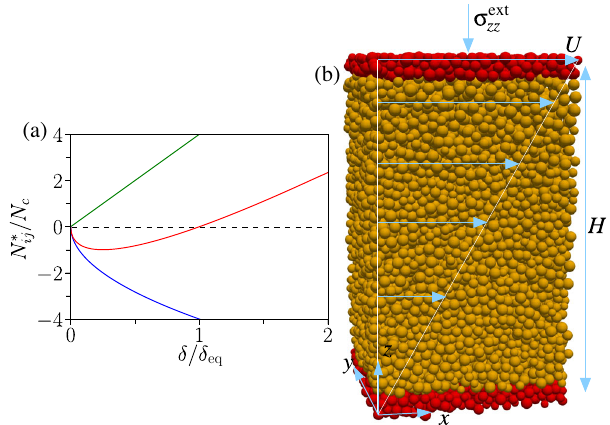
FIG. 1. Numerical model. (a) The normalized nonviscous normal contact forces ( N (cid:2) ij =N c ) as a function of the normalized overlap δ = δ : elastic component N el ij (green line), adhesive eq component N ad ij (blue line), and the sum of the two N tot ij (red line). N c is the pull-off force, and δ is the equilibrium overlap, eq as in Ref. [13]. (b) A simulation snapshot, showing a homo- geneous flow in the normal-stress-imposed plane shear cell. Red particles constitute the rough